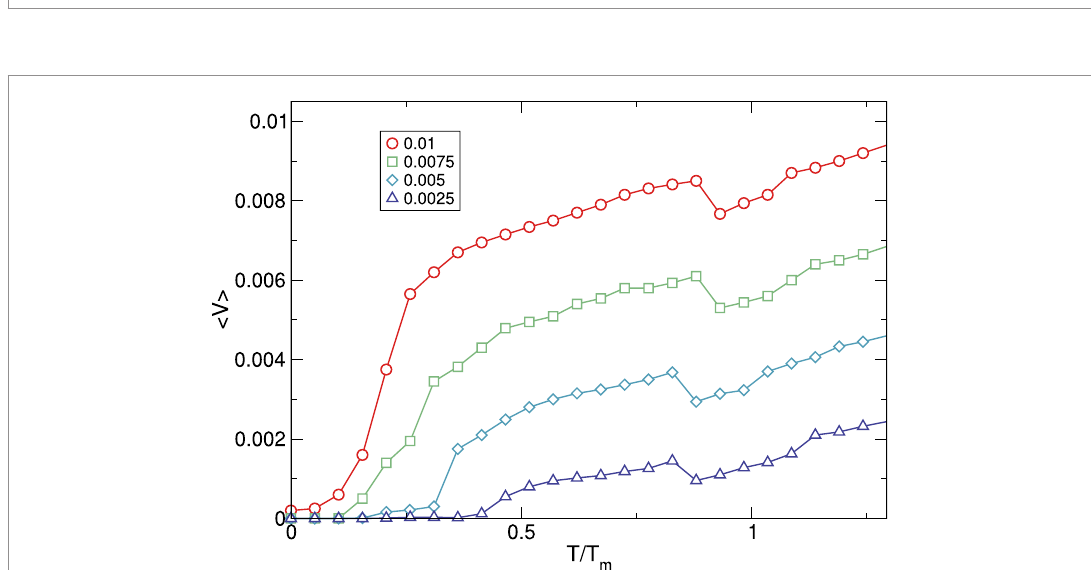
Figure 9. ⟨ V ⟩ vs T / T m curves for a system with σ = 0.12 and n p = 0 . 25 at F D = 0 . 01, 0.0075, 0.005, and 0.0025, from top to